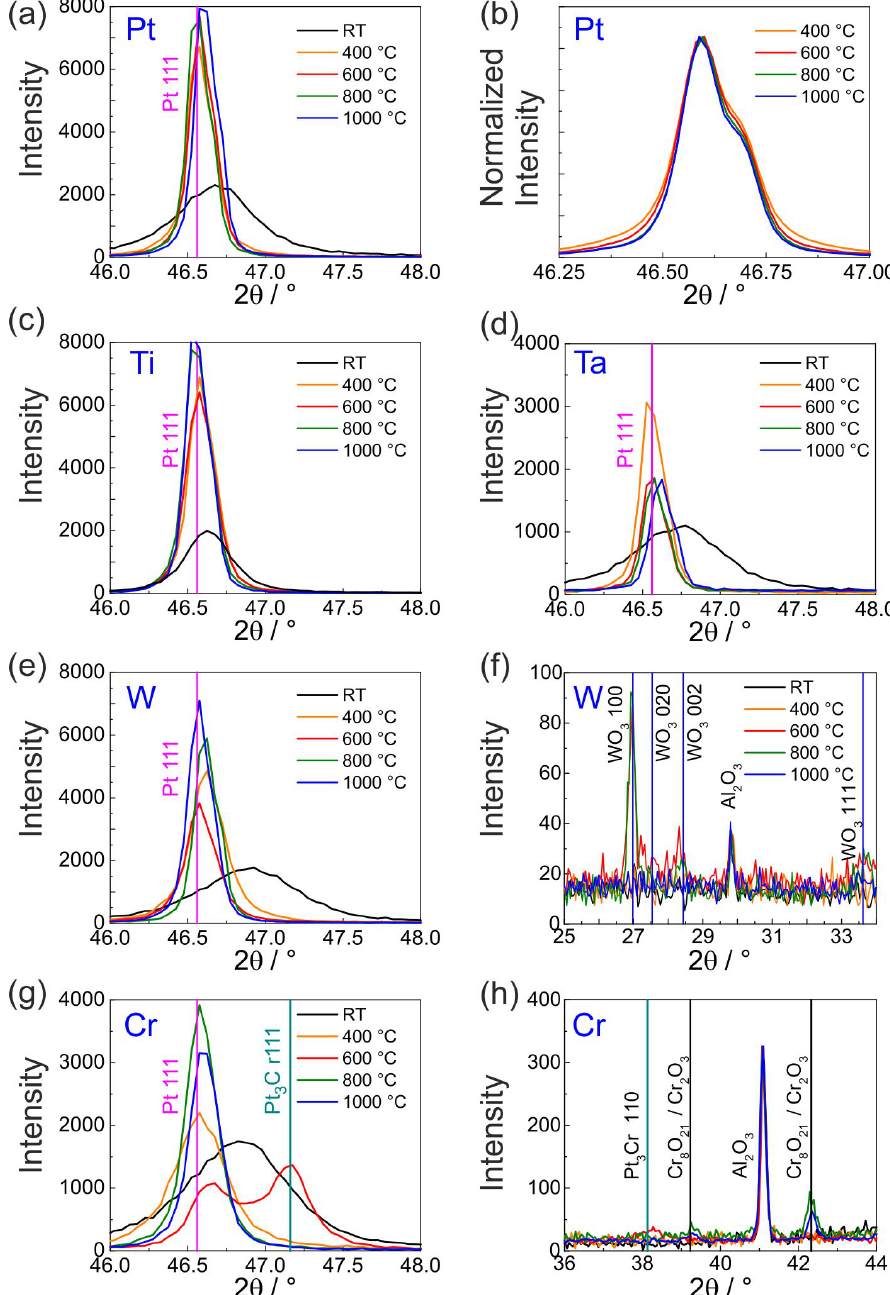
Figure 1. XRD diagrams of the Pt ∗ films on various seed layers in the as-deposited state (RT) and after annealing at 400, 600, 800 or 1000 ◦ C in air. ( a ) Pt; ( b ) Pt with normalized intensities for a better comparability of the peak width; ( c ) Ti; ( d ) Ta; ( e , f ) W showing the Pt and WO 3 reflexes; ( g , h ) Cr showing the Pt, Pt 3 Cr and Cr oxide